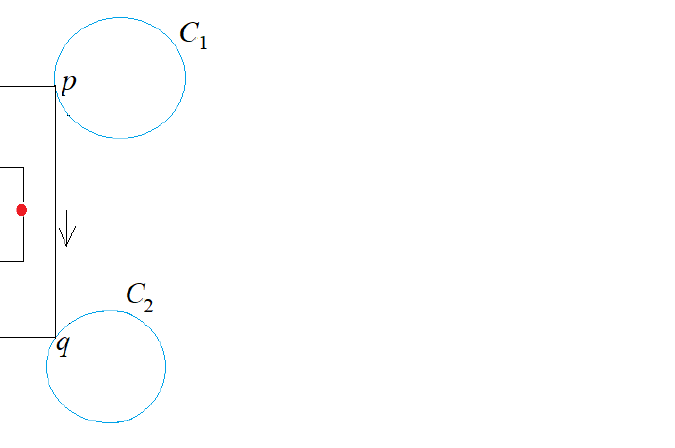
Figure 19. Case 4.1: No edge is pinned by any circle, and the position of p on C 1 ∈ NE is known. While sliding the CSR left-downward from S min , we first touch circle C 2 at corner q adjacent to p . The other two corners are uniquely determined.